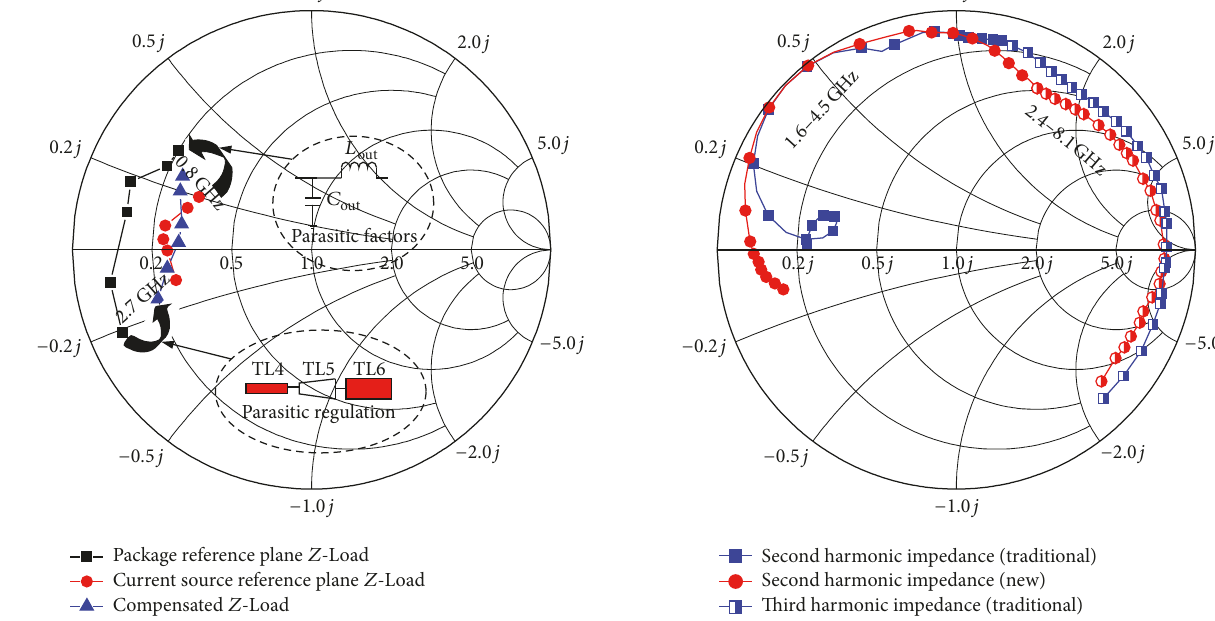
Figure 5: Simulated second and third harmonics impedance for conventional and improved